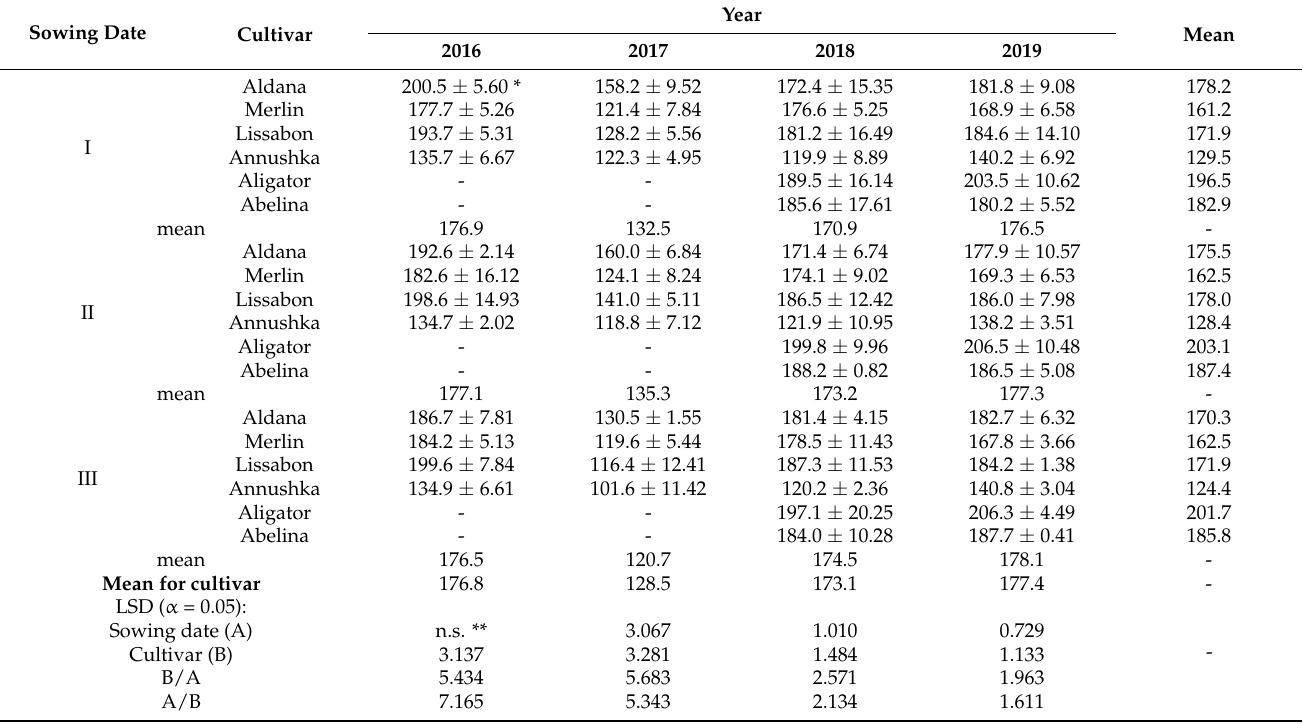
Table 9. Thousand seed weight depending on cultivar and sowing date